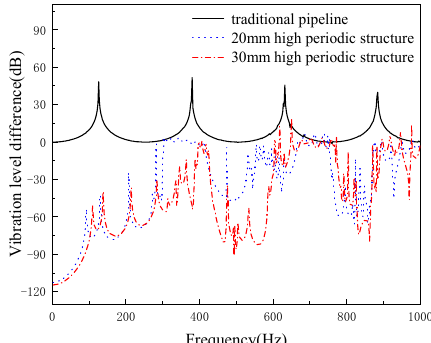
Figure 14. The effects of periodic structure height on cushioning performance (periodic structure width of 40 mm).